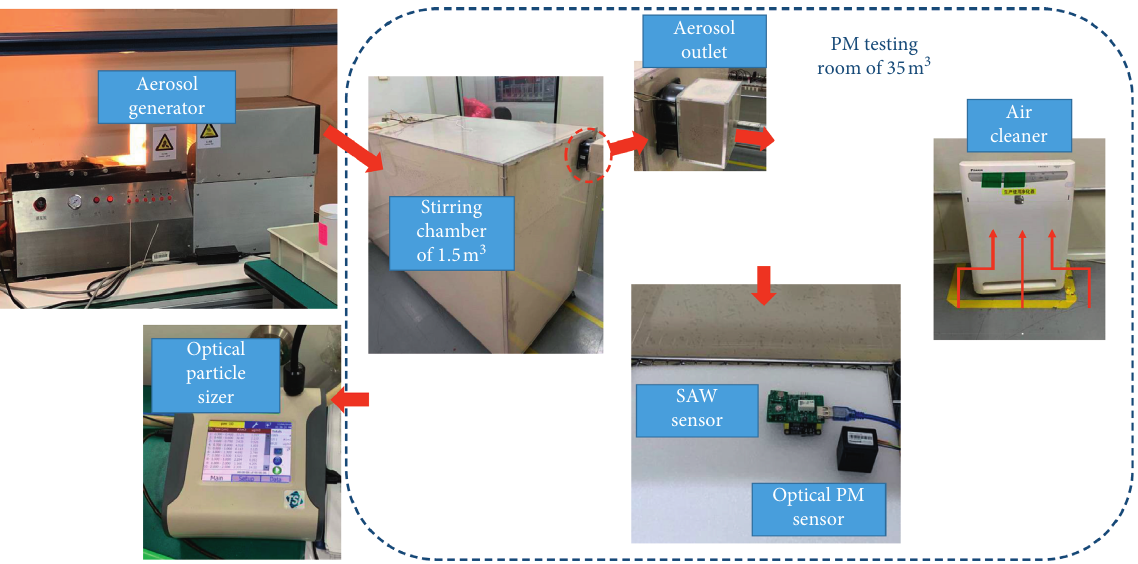
Figure 8: The setup of the 35m3 PM testing room.